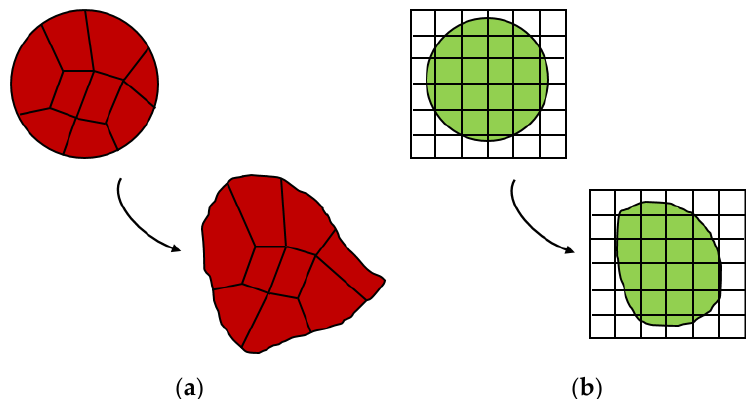
Figure 2. Continuum deformation using ( a ) Lagrangian and ( b ) Eulerian methods